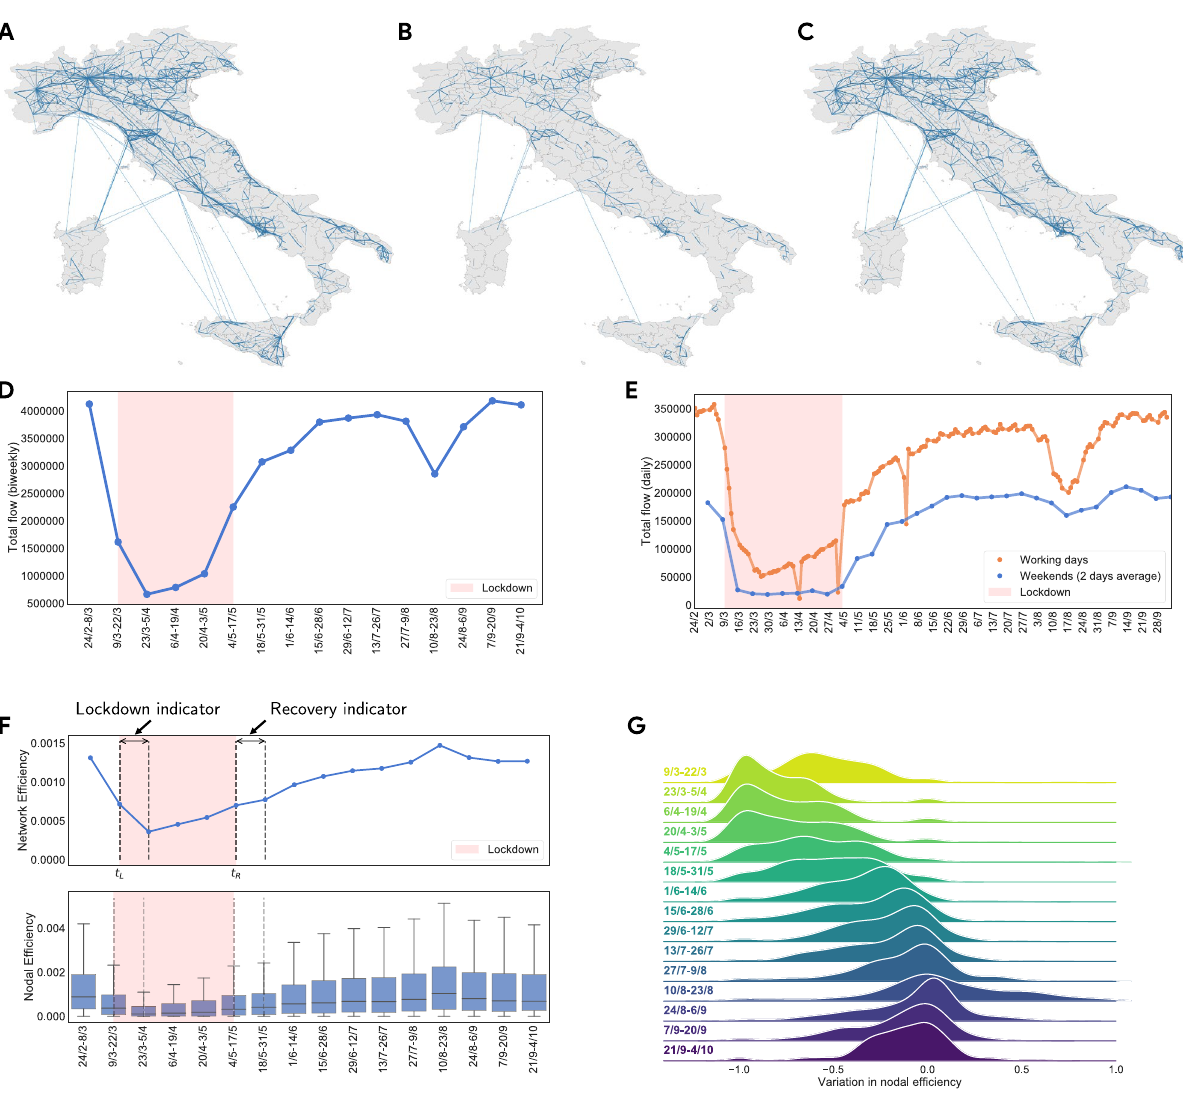
Figure 1. ( A – C ) Snapshots of Italian mobility during three distinct windows of 14-day, 24/2-8/3, 23/3-5/4, and 15/6-29/6, chosen to capture the pre-lockdown, lockdown, and recovery periods, respectively. Nodes represent LLMs and edges represent mobility flows between two locations, with thickness proportional to their weight. Figures created with Python (version 3.7.4) using networkx package (version 2.6.2) 55 . ( D ) Temporal evolution of the total number of individuals moving between LLMs, aggregated over windows of 14 days. ( E ) Temporal evolution of the total number of individuals moving between LLMs daily, separating working days from weekends. ( F ) Temporal evolution of the global network efficiency (top) and the distribution of nodal efficiency (bottom). We also annotate the periods in which we computed the two performance indicators, respectively Lockdown and Recovery. ( G ) Kernel density estimation of the distribution of relative variation (%) in nodal efficiency for each window w.r.t. the baseline